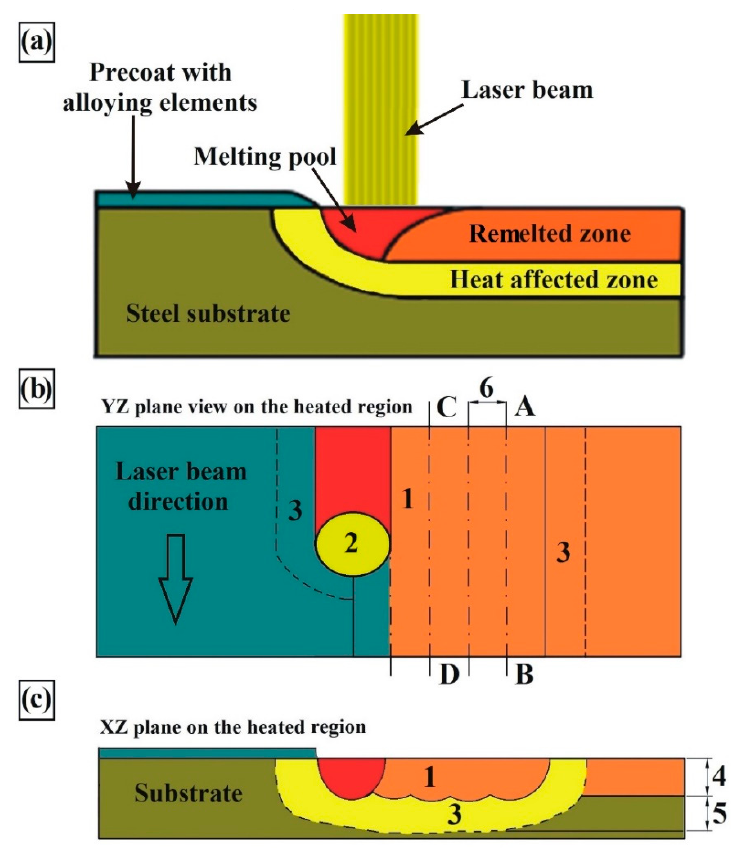
Figure 2. Scheme of laser alloying of steel substrate ( a ), YZ plane on the heat region ( b ), XZ plane on the heat region ( c ), 1—remelted zone, 2—laser beam, 3—heat affected zone, 4—remelted zone depth, 5—heat affected zone depth, 6—laser tracks overlapping.